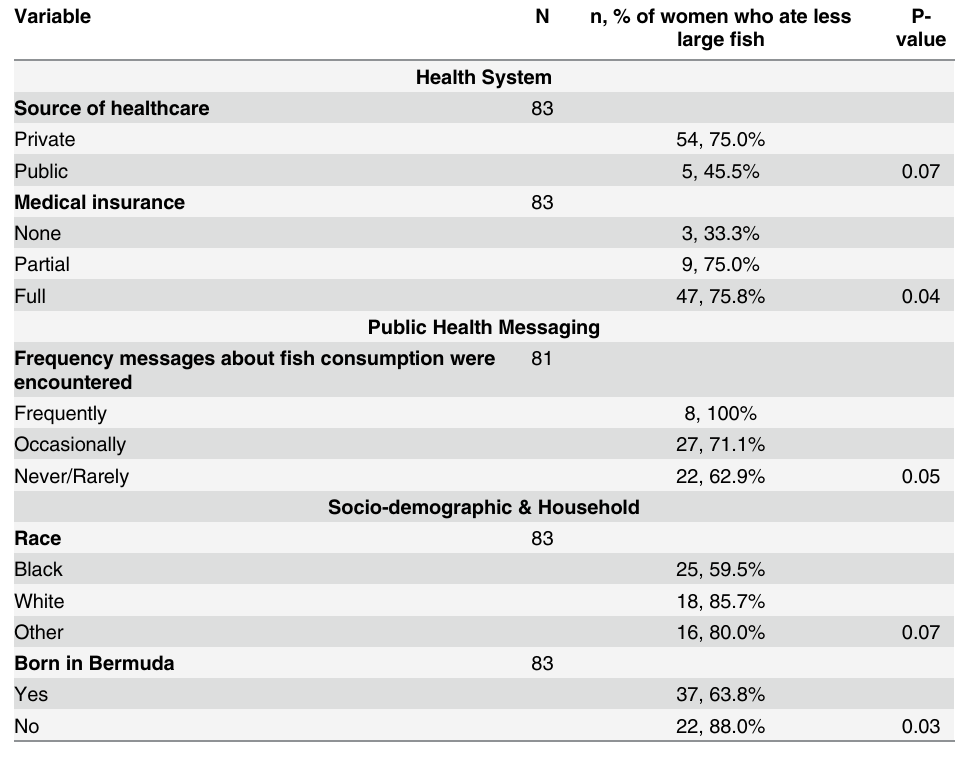
Table 3. Characteristics associated with reduced consumption of large fish species during preg- nancy, among those women who eat large fish 1,2 . Variable N n, % of women who ate less Source of